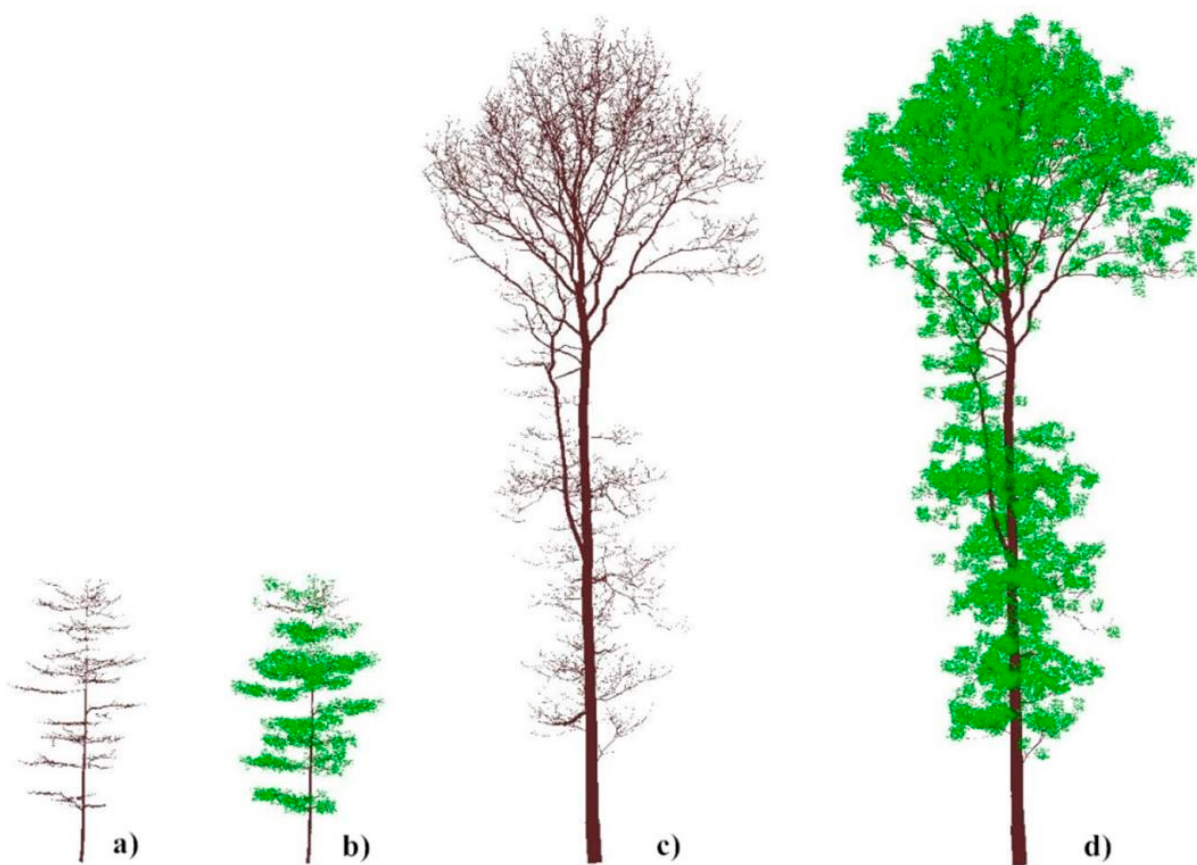
Figure 2. Example of the 3D individual tree models for virtual forests construction: ( a ) a 10 m beech tree without leaves, ( b ) a 10 m beech tree with leaves, ( c ) a 30 m oak tree without leaves, and ( d ) a 30 m oak tree with leaves. Table 1. Reference LAI and PAI values of the 30 virtual forest